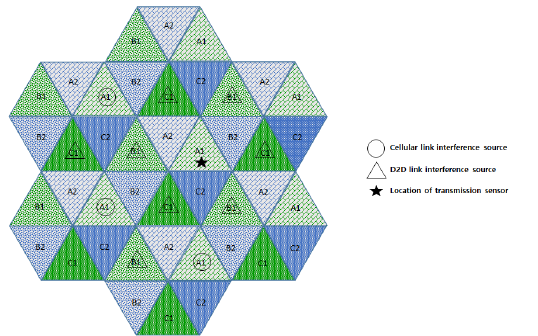
Figure 10. Interference sources to the target D2D link in an FFR-3